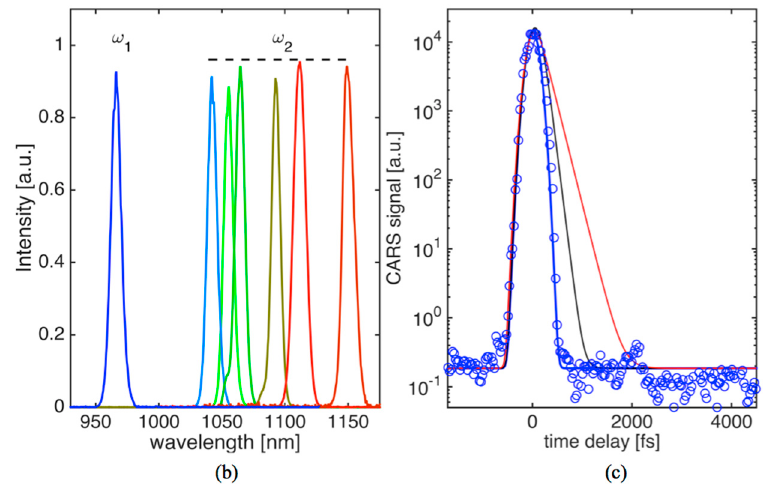
Figure 1. ( a ) Experimental set up. The three-color pulses at ω 1 , ω 2 , ω 3 are provided from lab built tunable femtosecond optical parametric oscillator (OPO 1,2 ) sources and a fixed wavelength Ti:sapphire oscillator (Coherent Mira) respectively. GR-diffraction grating 1200 L/mm, BP-bandpass filter, CL-collimating lens objective. Galvo-scanner is from Cambridge Technology, Inc. (Bedford, MA, USA) (model #6210), photomultiplier tube (PMT) is from Hamamatsu-USA (Bridgewater, NJ, USA) (model #H9305), data acquisition card (DAQ) is from National Instruments (model 6201); ( b ) OPO 1,2 spectra for nearly transform limited E 1,2 pulses used for coherent anti-Stokes Raman scattering (CARS) experiments; ( c ) Time-domain CARS signal (open circles) obtained from microscope glass when the OPO wavelengths were set to 967 nm and 1152 nm. The transient signal represents instrument function that allows measurement of dephasing times (T 2 ) shorter than 150 fs. Solid curves are simulated CARS signals that make use of Equations (3) and (4), and assuming single exponential decay for G ( t ) with 150 fs (black) and 250 fs (red) dephasing times. GR: diffraction grating; BP: bandpass filter; CL: collimating lens; OBJ: objective lens.